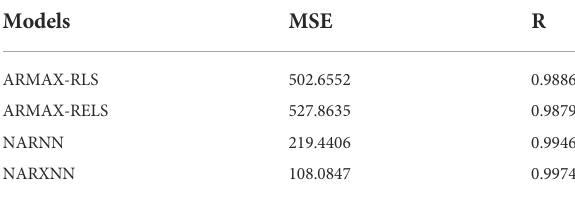
TABLE 3 Exogenous input variables related to the steel plant and